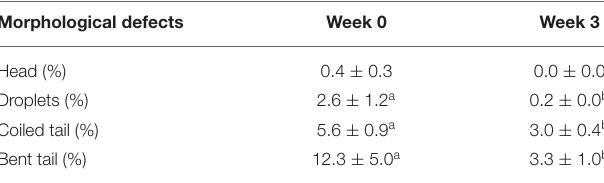
TABLE 2 | Sperm morphological defects in the first and last week of supplementation. Morphological